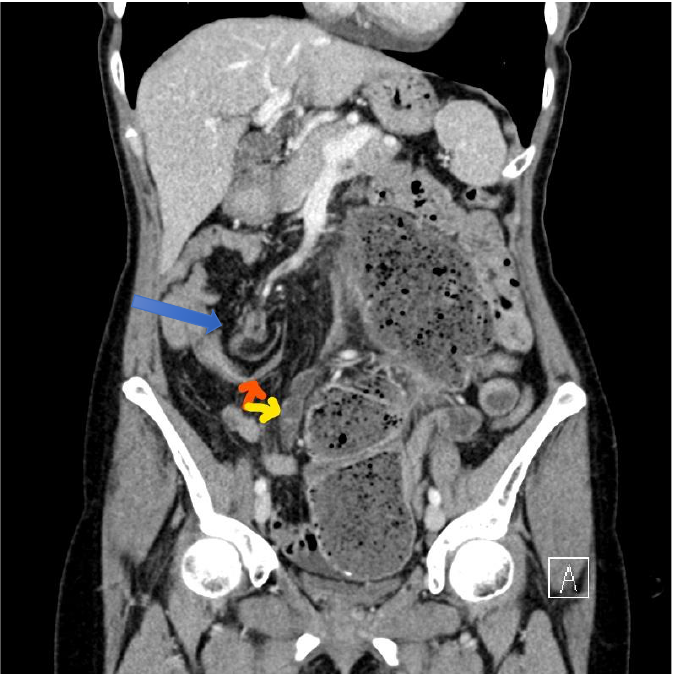
Figure 6. CT coronal image demonstrating the X-marks-the-spot sign. Double transition points have been marked (hand-drawn yellow and red arrows). There is also a whirl sign (blue arrow).